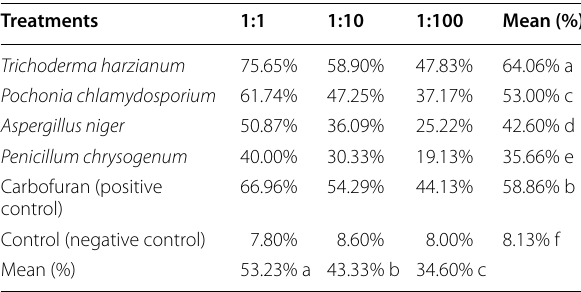
Each value is the mean of 5 Replications. A letter followed by the same alphabet doesn’t differ significantly